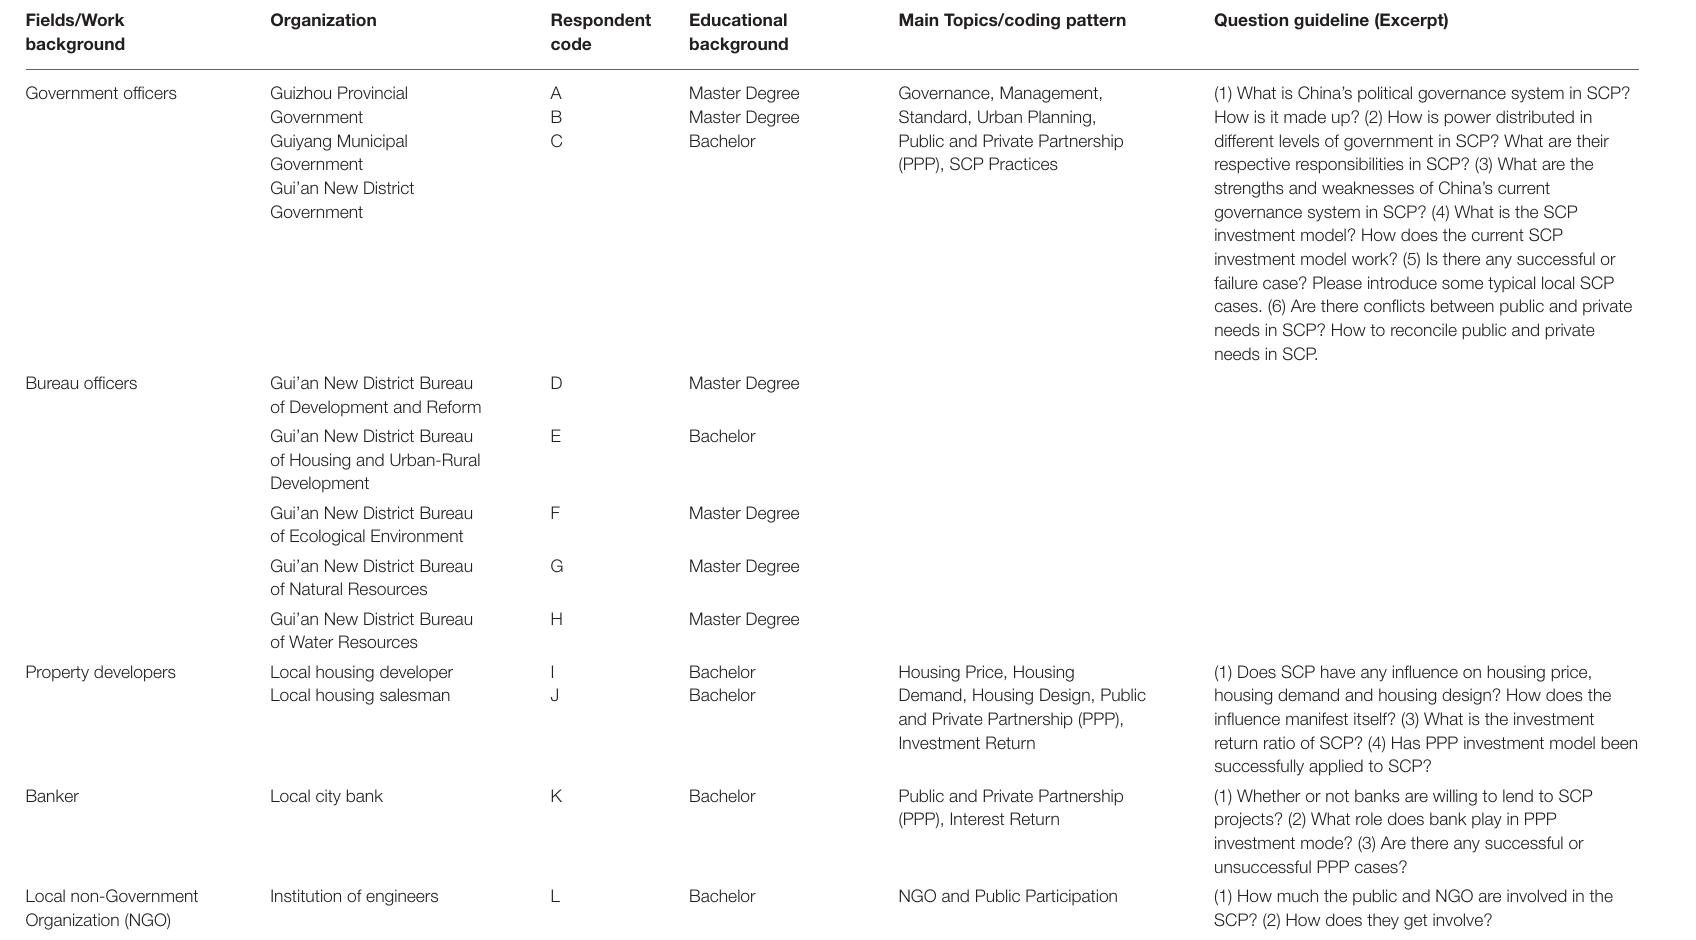
TABLE 1 | Respondent characteristics and relevant information. Fields/Work